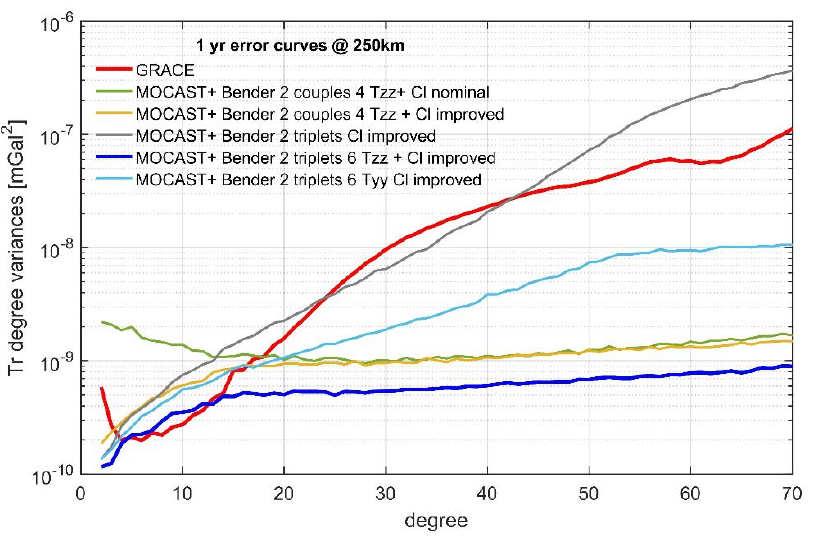
Figure 8. Noise spectra of five different mission scenarios of MOCAST+, compared to the noise curve of GRACE [2,3].